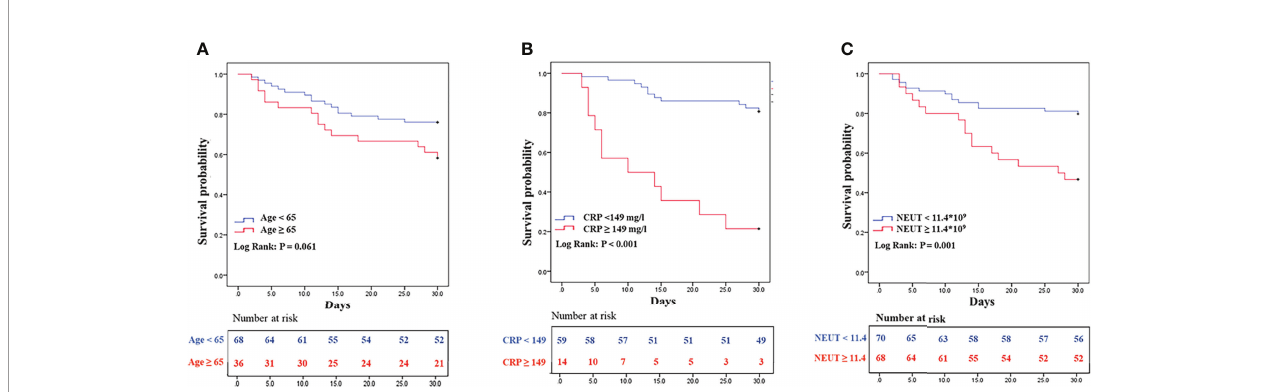
FIGURE 4 | Kaplan – Meier survival plots, (A) Age; (B) CRP; (C) NEUT; NEUT, neutrophil; CRP, C-reactive